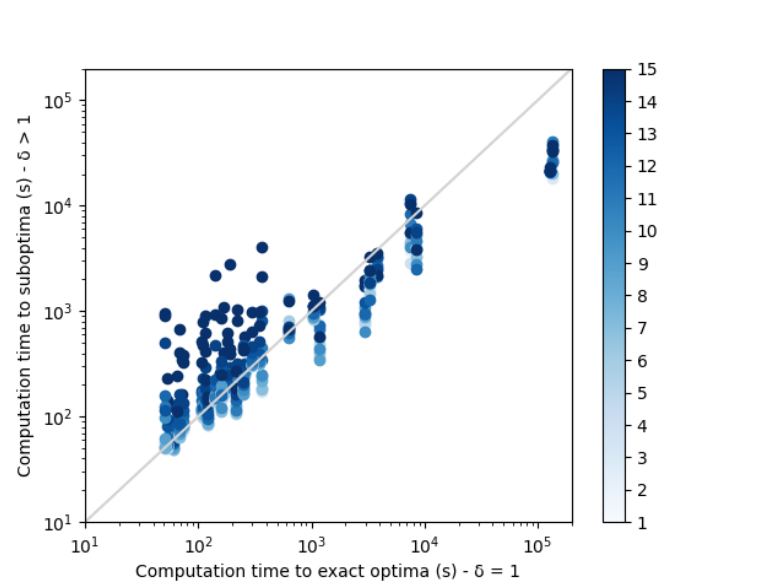
Figure 12. Comparison of the computation times of sequence sets without diversity δ = 1, with suboptimal sequence sets with diversity δ > 1. An energy gap of 3 kcal/mol is allowed for actual op-